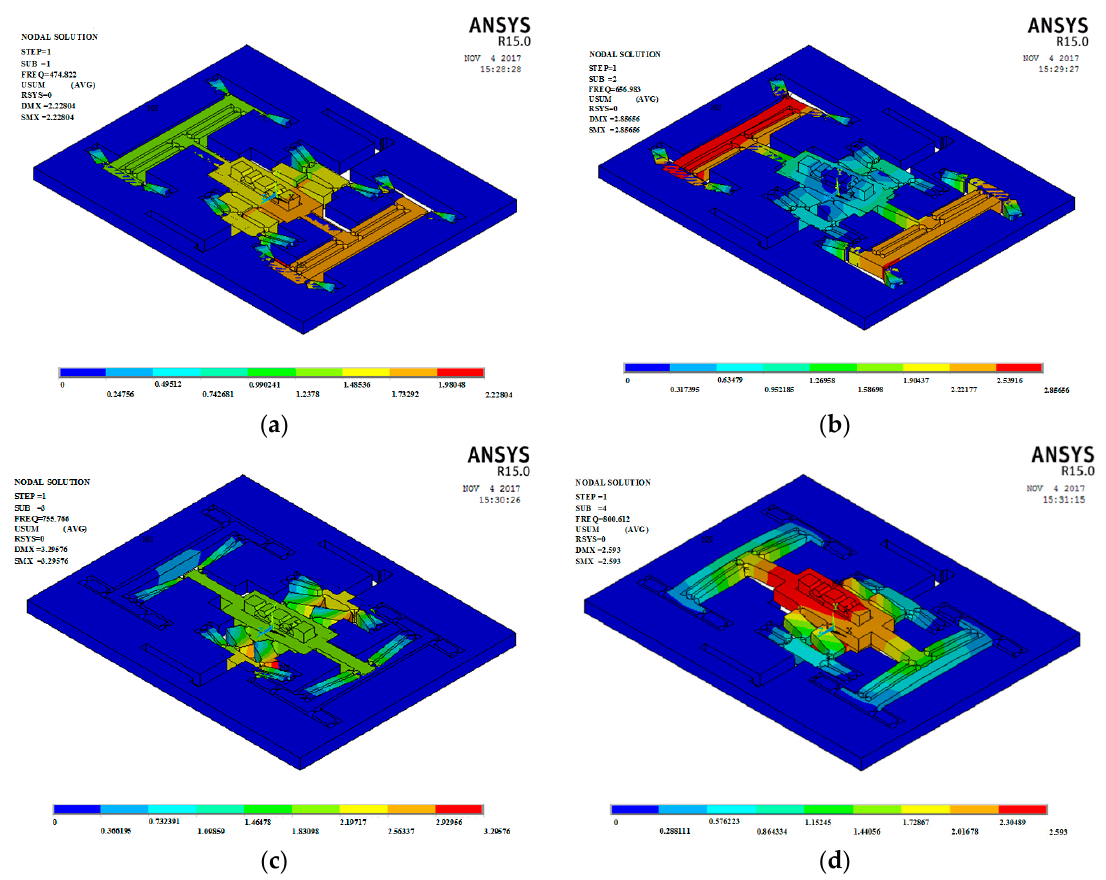
Figure 22. Modal analysis of 3-DOF device. ( a ) Mode 1; ( b ) Mode 2; ( c ) Mode 3; ( d ) Mode 4.